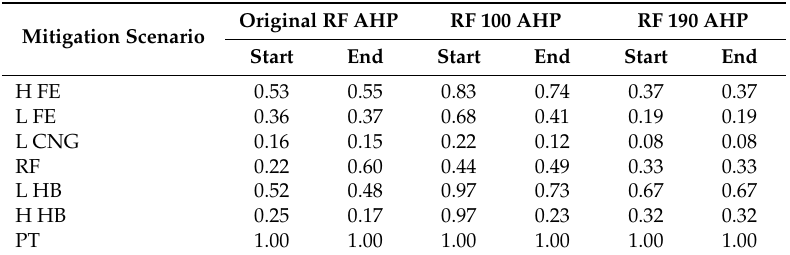
Table 4. Preferences of workshop participants (un-normalised